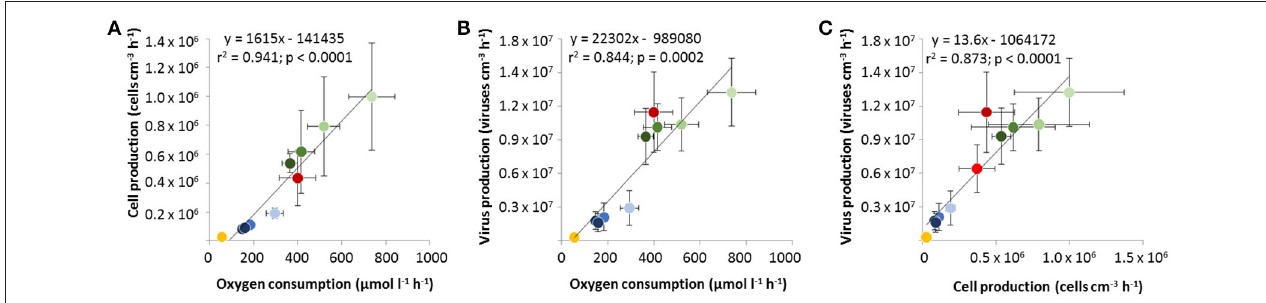
FIGURE 4 | Linear correlations of net virus production rates, net cell production rates and oxygen consumption rates of experiments in reactors, respectively (see also Table S1). Significant ( p < 0.01) correlations for (A) cell production rates versus oxygen consumption rates, (B) virus production rates versus oxygen consumption rates and, (C) virus production rates versus cell production rates. Yellow: experiment with beach sediment in November, blue: experiment with Janssand sediment in February (dark blue: long columns, blue: medium column, light blue: small column), dark red: experiment with Janssand sediment in July, bright red: experiment with Janssand sediment in June (note that there are no data for oxygen consumption because with this sediment the effluents of the columns were anoxic), green: experiment with Janssand sediment in August (darkest green: longest columns, dark green: long column, green: medium column, light green: small column).